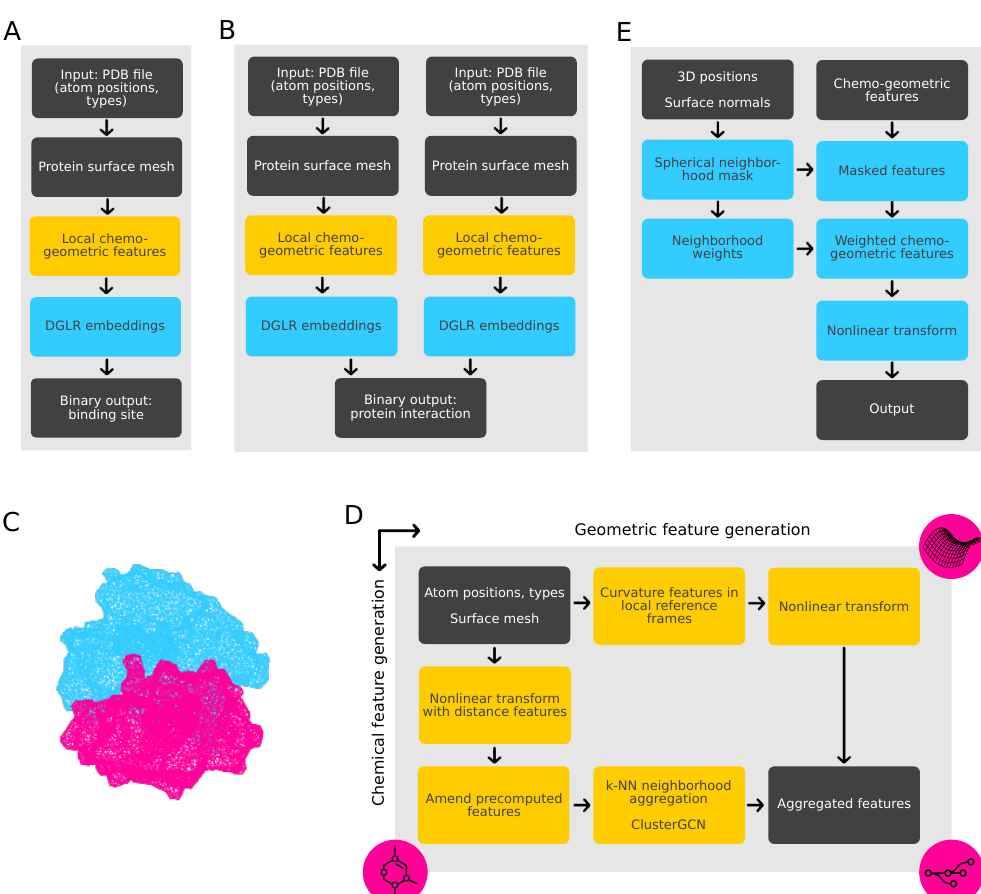
Figure 2. Model details. ( A ) Overall workflow for binding site prediction. The model outputs binary predictions of site activity for different points on the surface of proteins which are input via PDB